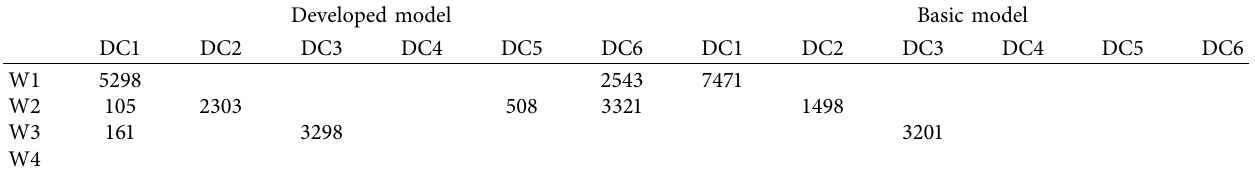
Table 4: Total products transported from warehouses to distribution centers.